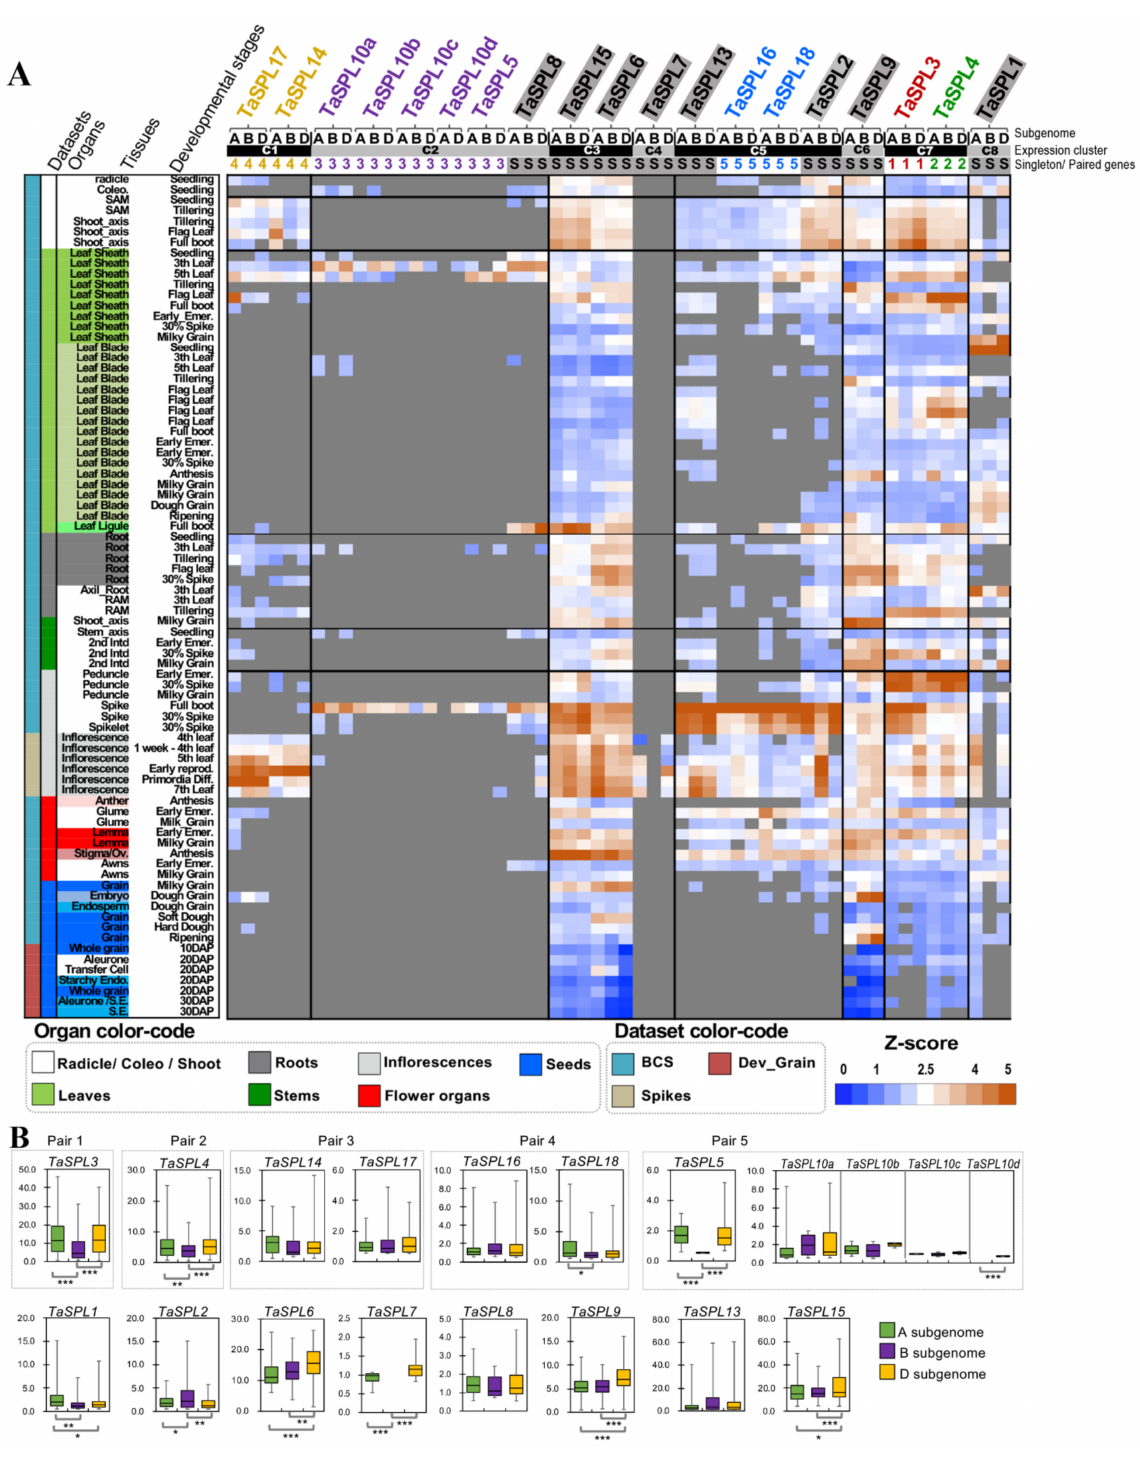
Figure 2. Expression analyses of TaSPL s emphasizing the divergence of some TaSPL s, in terms of spatial– temporal expression patterns: ( A ) RNA-seq based expression of TaSPL s. Each column represents a TaSPL gene, and each row represents an RNA-seq sample, with the RNA-seq data sets, tissues, and stages labeled on the left. A, B, D indicate the sub-genome that each TaSPL gene is located on. In Figure 1A, singleton TaSPL s are shaded in gray, while evolutionarily paired TaSPL s are highlighted using colors, with red, green, gold, blue, and purple indicating Pair 1, Pair 2, Pair 3, Pair 4, and Pair